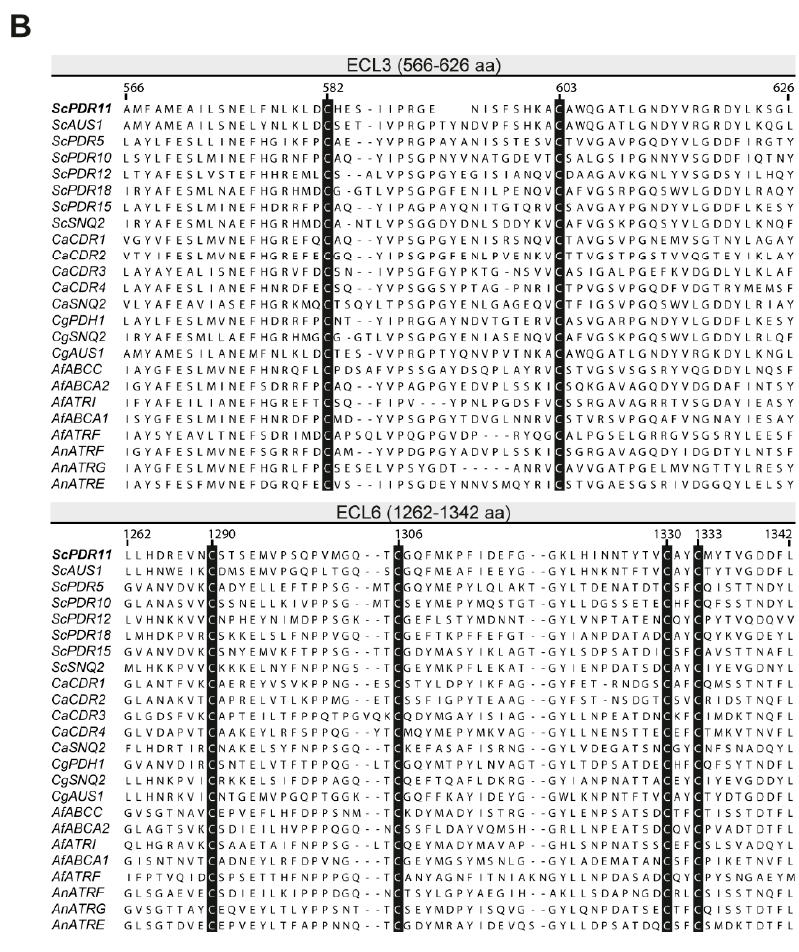
Figure 1. Structural features of Pdr11p. ( A ) The topological model of Pdr11p showing two transmembrane domains (TMD), each comprising six transmembrane helices, preceded by a nucleotide-binding domain (NBD). Cysteine residues in the two large extracellular loops, ECL3 and ECL6, are highlighted in black. Dashed lines indicate the recognition sites of caspase-1 at positions D724 and D876. ( B ) Partial amino acid sequence alignment of ECL3 and ECL6 from fungal ABC transporters. Conserved cysteine residues are indicated in black boxes. The transporters shown are from S. cerevisiae ( Sc PDR11, Sc AUS1, Sc PDR10, Sc PDR15, Sc PDR5, Sc PDR12, Sc PDR18 and Sc SNQ2), Candida albicans ( Ca CDR1, Ca CDR2, Ca CDR3, Ca CDR4, Ca SNQ2), Candida glabrata ( Cg PDH1, Cg SNQ2, Cg AUS1), Aspergillus fumigatus ( Af ABCC, Af ABCA2, Af ATRI, Af ABCA1, Af ATRF) and Aspergillus nidulans ( An ATRF, An ATRG, An ATRE). Accession numbers are listed in material and methods.